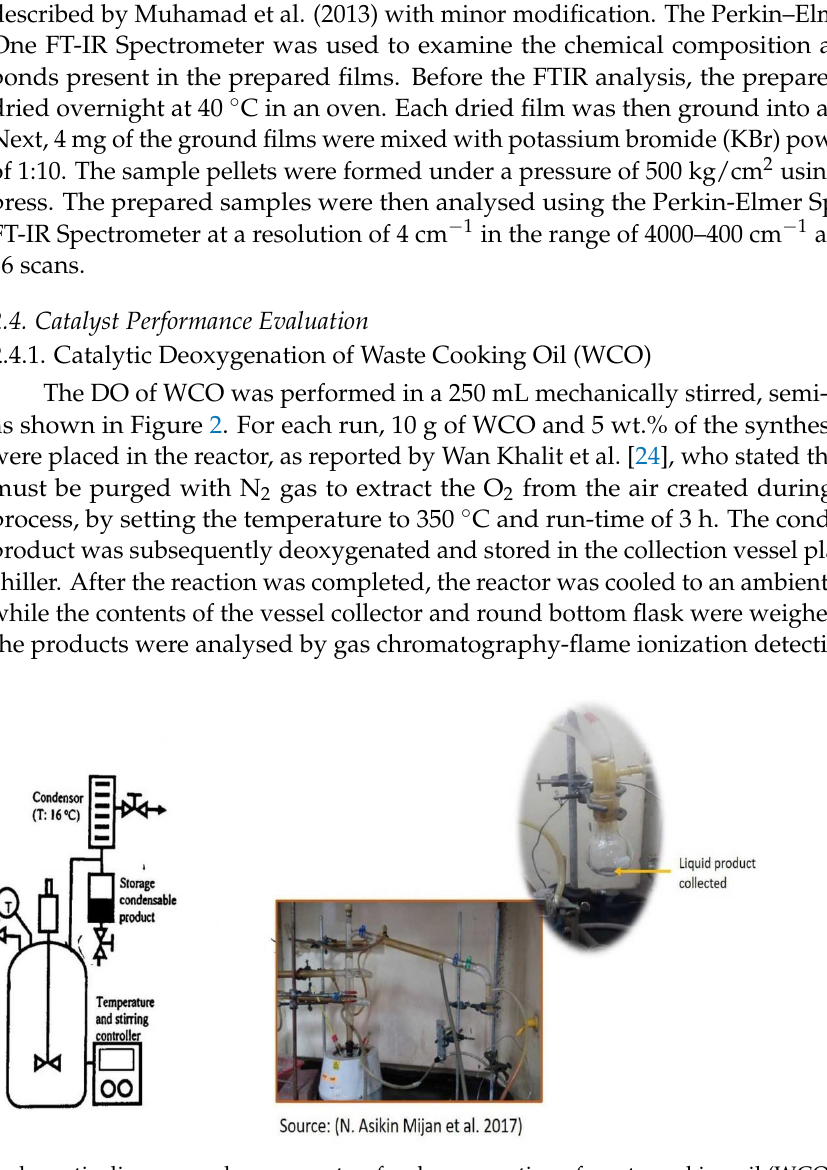
Figure 2. Semi-batch schematic diagram and process setup for deoxygenation of waste cooking oil (WCO).